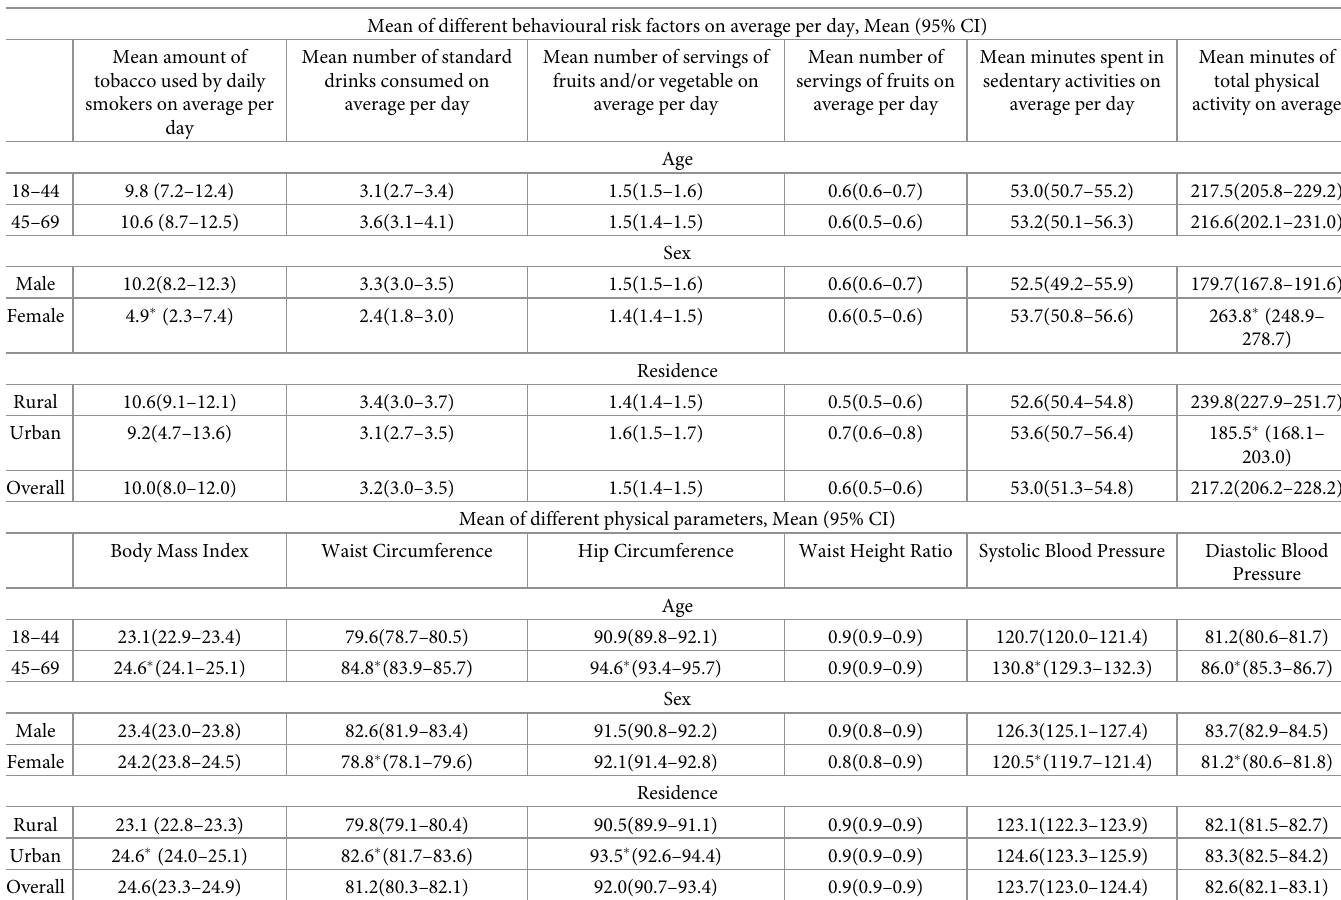
Table 3. Means (confidence intervals) of different parameters for behavioral information and physical measurements in population of Haryana, 2016–2018. Mean of different behavioural risk factors on average per day, Mean (95%